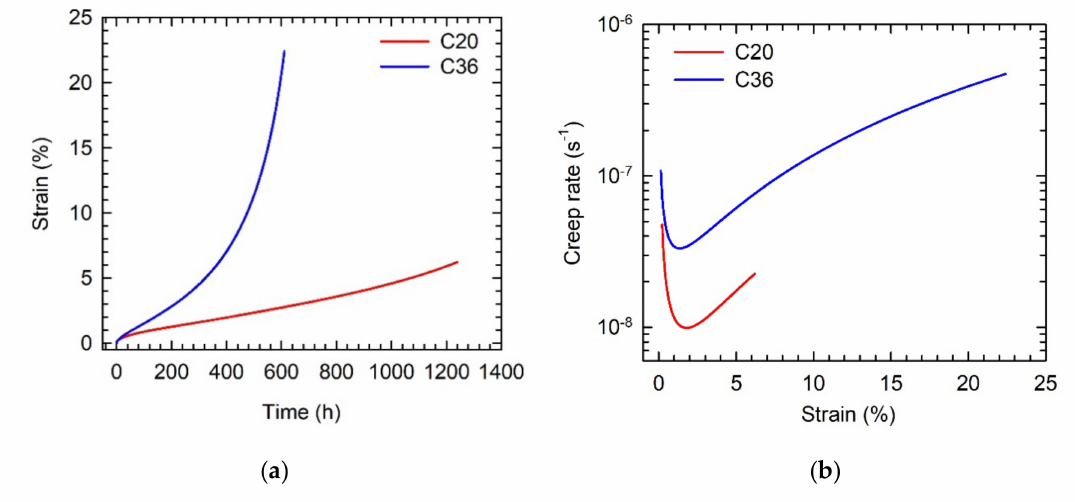
Figure 9. Creep deformation curves of C20 and C36 alloys at a temperature of 800 ◦ C and applied stress of 200 MPa: ( a ) Dependence of creep strain on time; ( b ) Dependence of creep rate on strain. The studied alloys are indicated in the